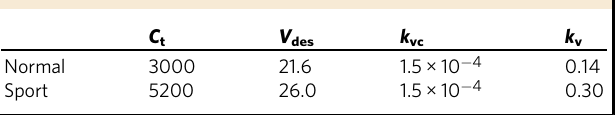
Table 1 Driver ’ s Risk Field parameters. Table 2 Driver model parameters.